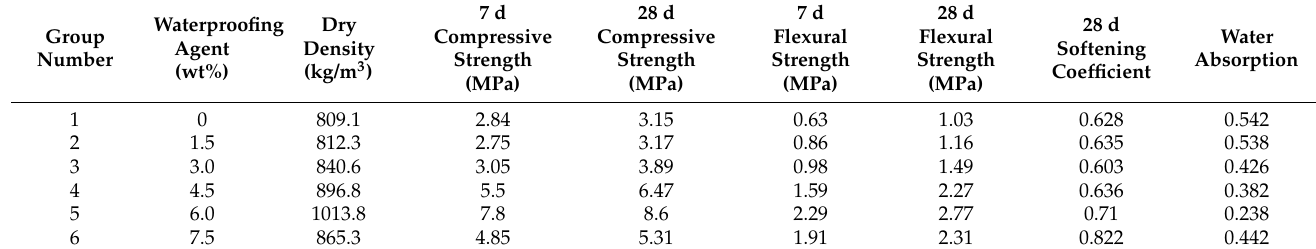
Table 9. Optimization results of specimens with different waterproofing agent contents.